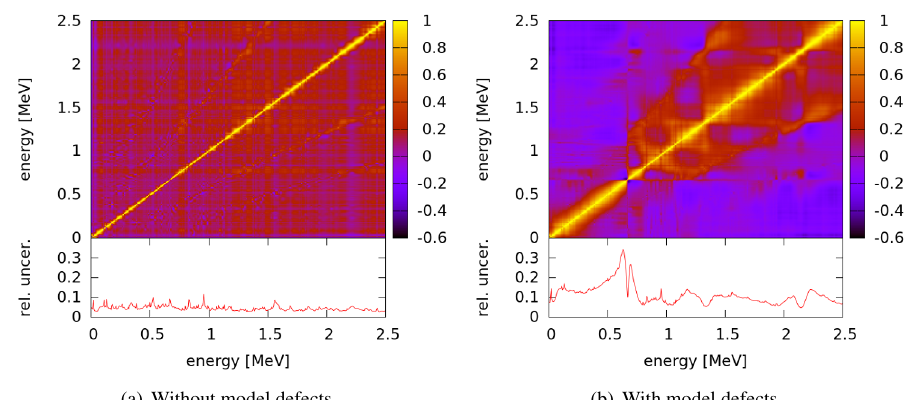
Figure 5. Correlation associated to matrix A 1 evaluated without (left) and with (right) model defects. √ A 1 ( E i , E i ) /σ true is In the inset below the relative uncertainty